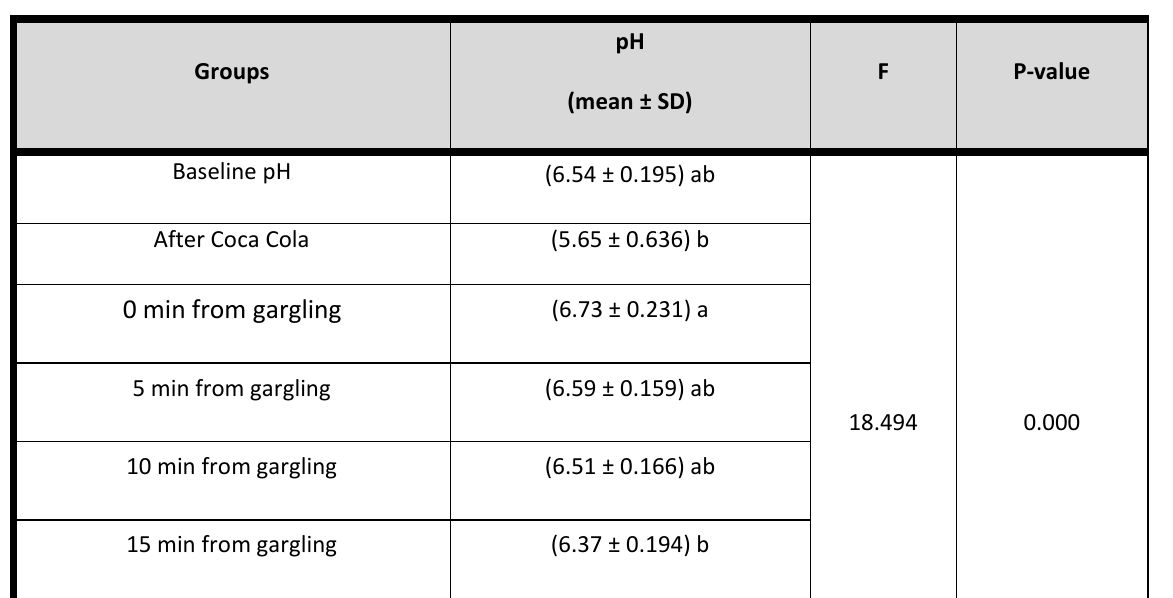
a: homogenous group, b significant differences at p ≤ 0.05.